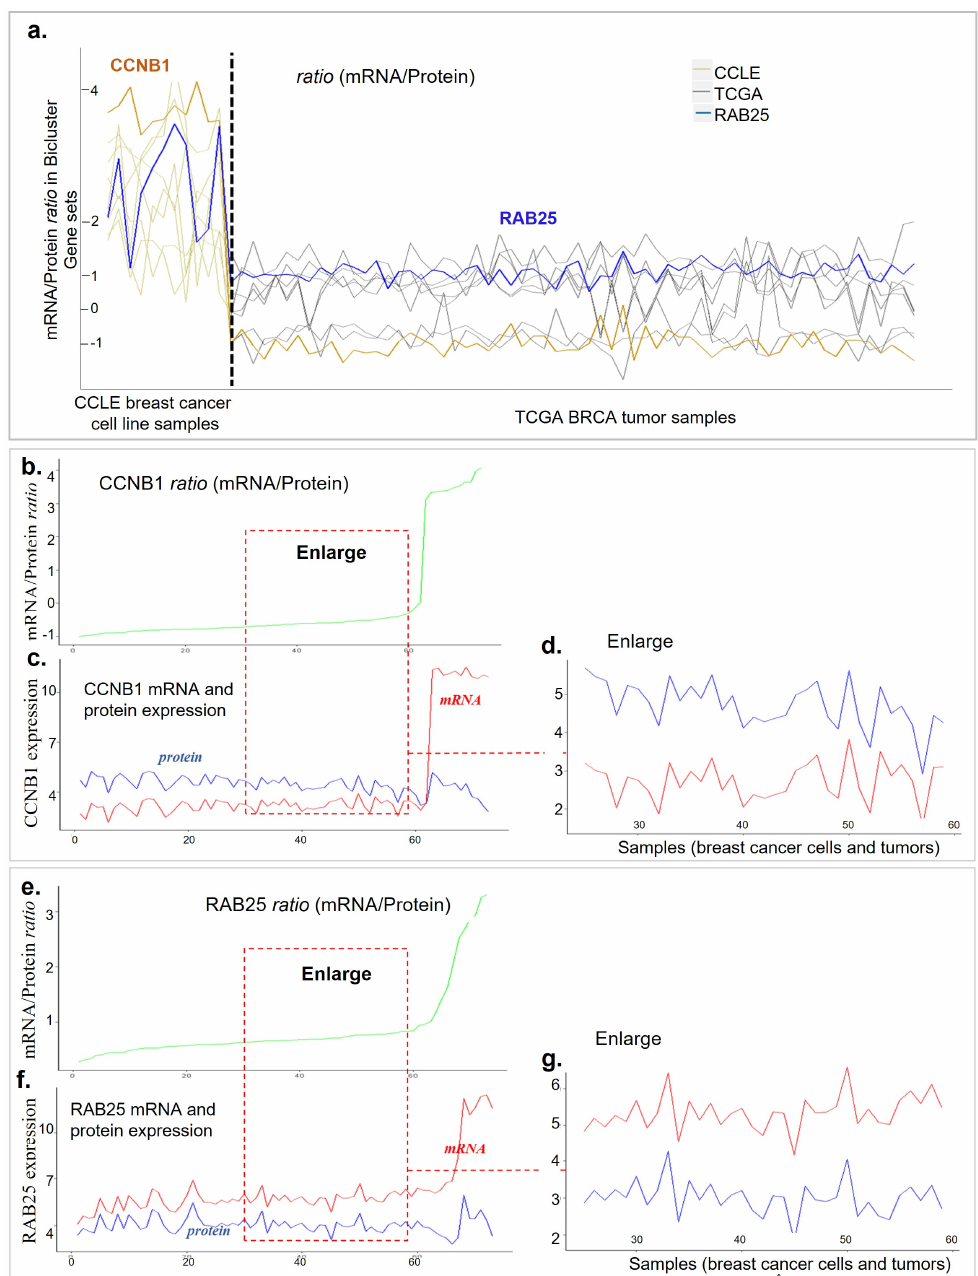
Figure 6. ( a ) Changes in the mRNA–protein ratio level of all genes across samples in the basal-like bicluster in breast cancer. The blue line is the ratio level of RAB25 and the gold line is CCNB1. ( b ) The mRNA–protein ratio level of CCNB1 across samples in the bicluster. Samples are sorted by ratio measurement. ( c ) The expression level of gene CCNB1 (red) and protein (blue) across all samples in the basal-like bicluster. Samples keep the same order as in ratio in ( b ). ( d ) The mRNA–protein ratio level of CCNB1 across 34 samples in the bicluster. ( e ) The mRNA–protein ratio level of RAB25 across samples in the bicluster. Samples are sorted by ratio measurement. ( f ) The expression level of gene RAB25 (red) and protein (blue) across all samples in the basal-like bicluster. Samples keep the same order as in ratio in ( e ). ( g ) The mRNA–protein ratio level of RAB25 across 34 samples in the bicluster.